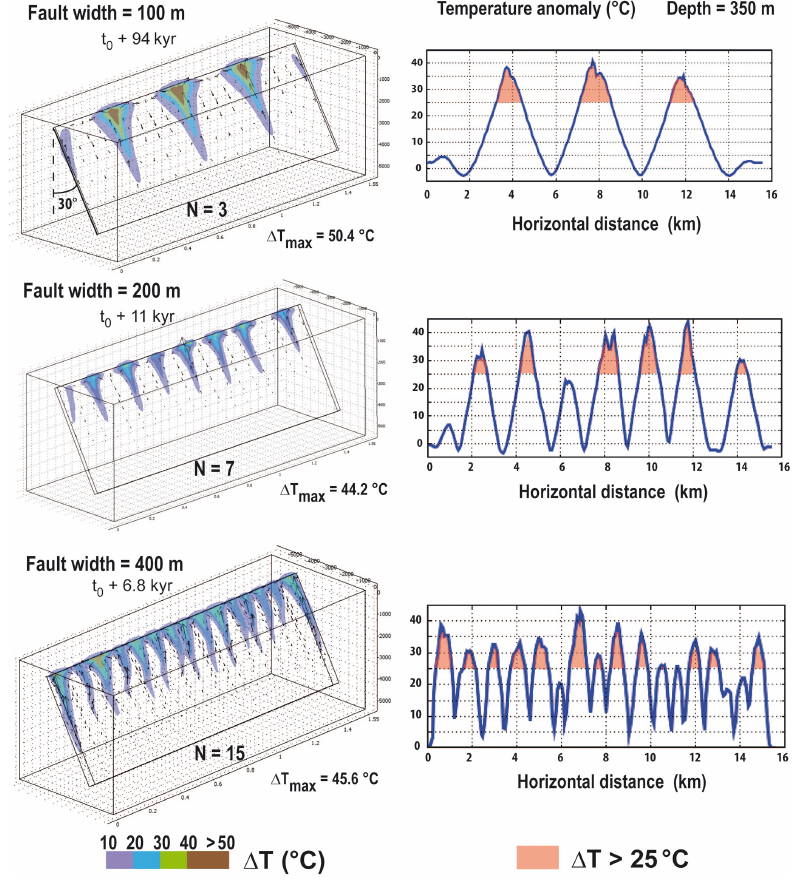
Figure 12. Effect of fault width on temperature anomaly pattern for a dip angle of 30 ◦ and the same permeability law as in Fig. 11. Values of maximal temperature anomalies are similar, but the wider the fault, the more numerous the positive thermal anomalies. Temperature anomalies greater than 25 ◦ C at a depth of 350m are highlighted on the right.